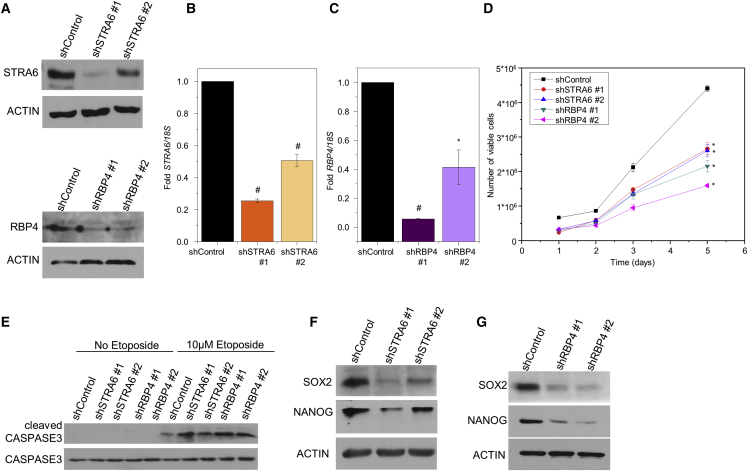
RBP4-STRA6 Pathway Is Necessary for Expression of CSC Markers(A) Cell lysates from SW480 cells transfected with non-target, STRA6, or RBP4 shRNA were run on SDS-PAGE and immunoblotted with indicated antibodies.(B and C) mRNA levels of STRA6 (B) and RBP4 (C) in the indicated SW480 stable lines. Data are presented as mean ± SD from n = 3 independent experiments ∗p < 0.05; #p < 0.01.(D) Viability of SW480 cells stably expressing control, STRA6, or RBP4 shRNAs measured in triplicates for 5 days using trypan blue and Countess II FL. Data are presented as mean ± SE. ∗p < 0.05, significant difference between control and individual cell lines at each time point.(E) Representative immunoblots of total and cleaved caspase-3 on cells in (A) treated with 10 μM etoposide for 72 hr.(F and G) Representative immunoblots from three independent experiments showing levels of SOX2 and NANOG in SW480 stable lines. Cells were grown in delipidated medium for 18 hr before harvesting. Actin was used as loading control.